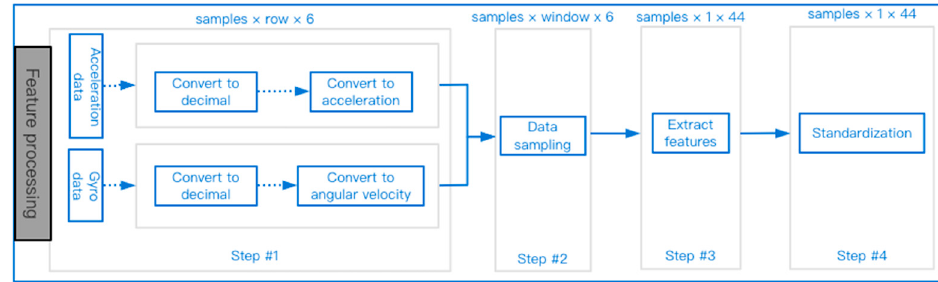
Figure 3. Data preprocessing process.